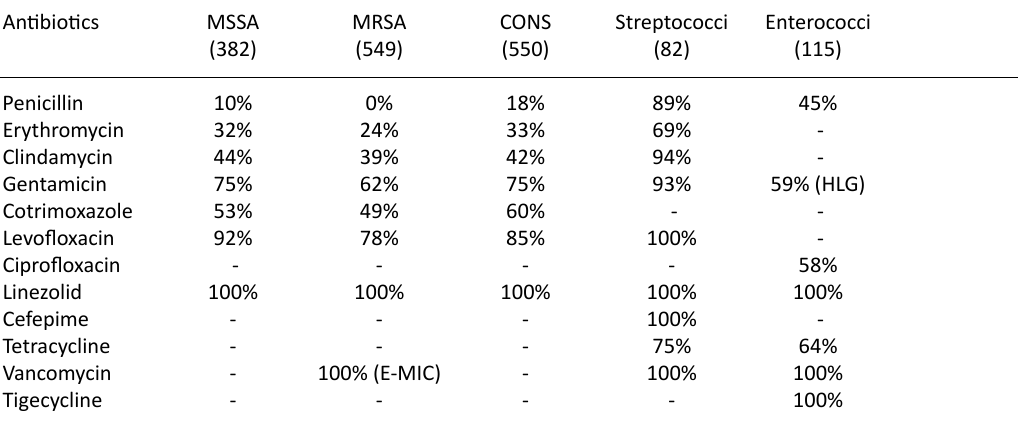
Table 2. Antimicrobial sensitivity of Gram positive cocci Antibiotics